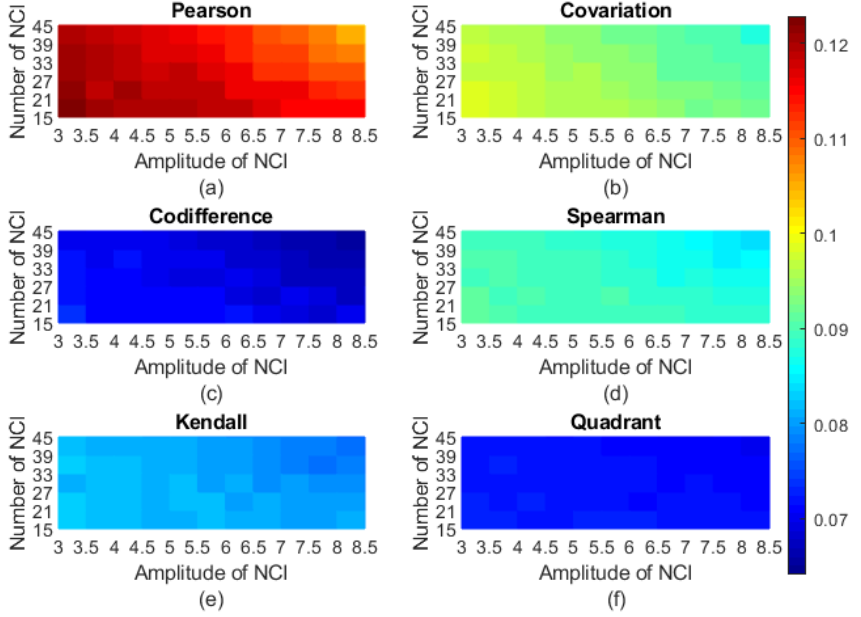
Figure 12. IMPI—impulsiveness indicator calculated for tested IFB at 2–3 kHz in the case of different measures of dependence: ( a ) Pearson autocorrelation, ( b ) autocovariation, ( c ) autocodifference, ( d ) Spearman autocorrelation, ( e ) Kendall autocorrelation, ( f ) Quadrant autocorrelation.